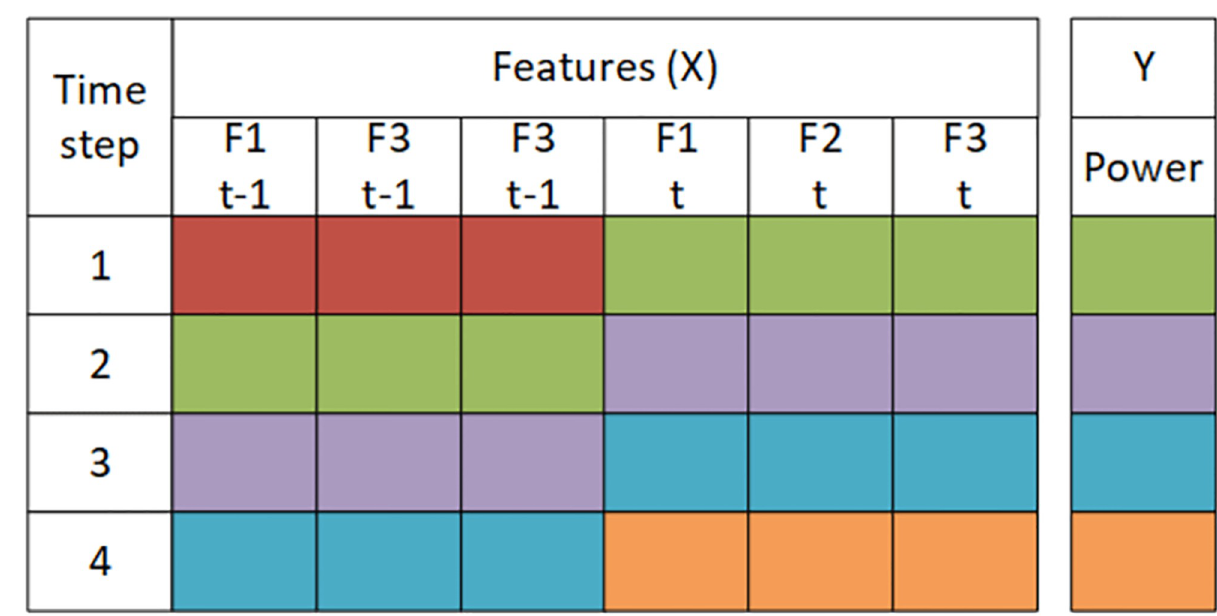
Fig 2. This figure illustrates the form of the dataset for lookback =